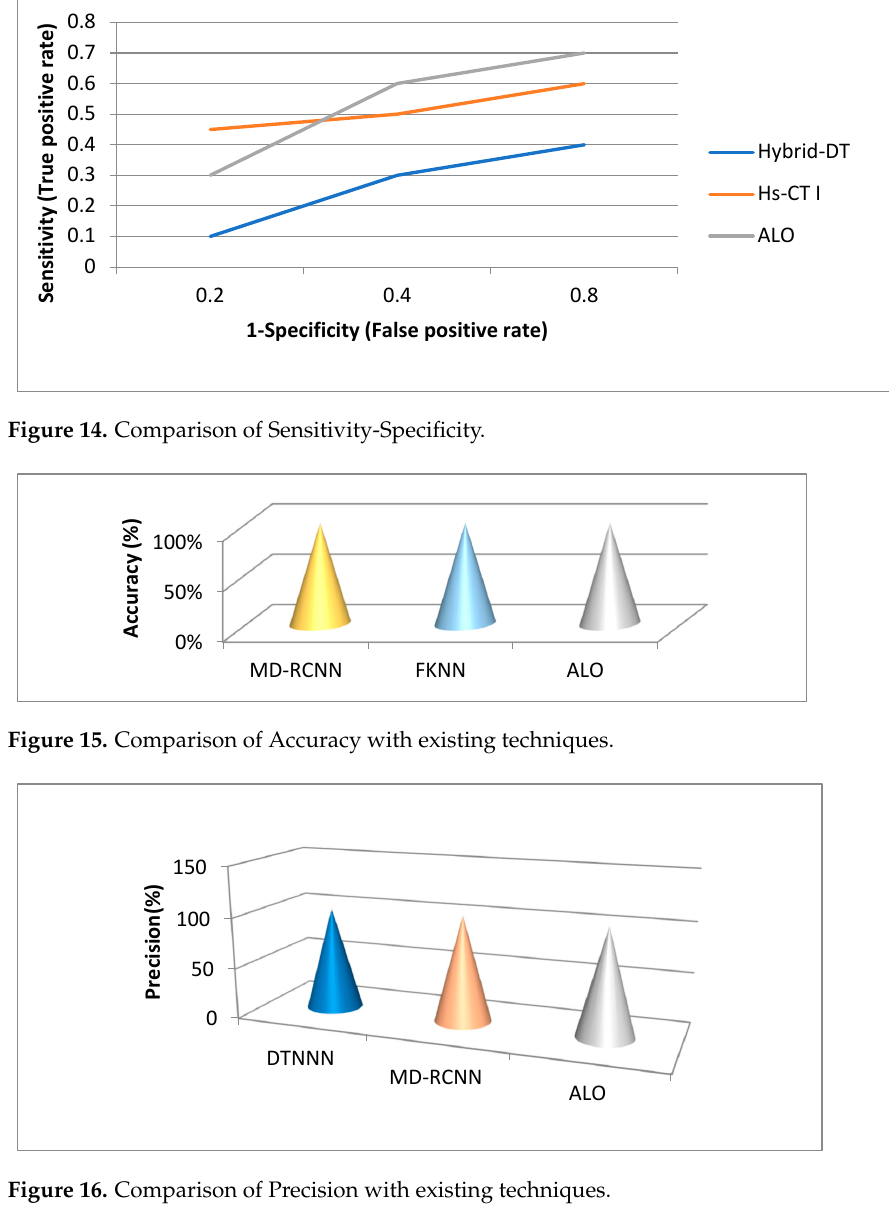
Figure 16. Comparison of Precision with existing techniques.